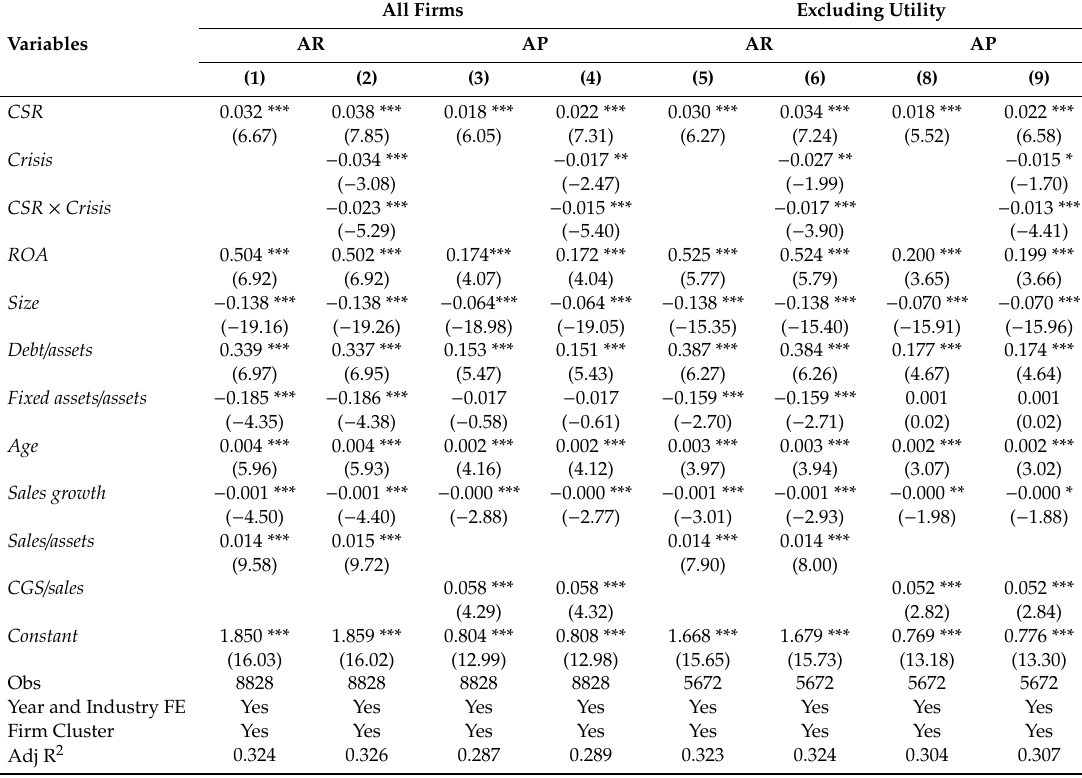
Table 6. Sample 2005–2012 with all firms and excluding the regulated utility